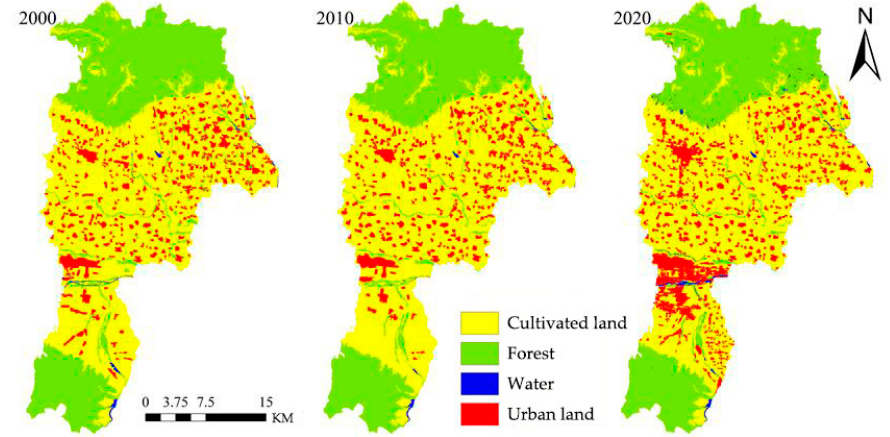
Figure 3. Land use maps of Qishan in 2000, 2010 and 2020.